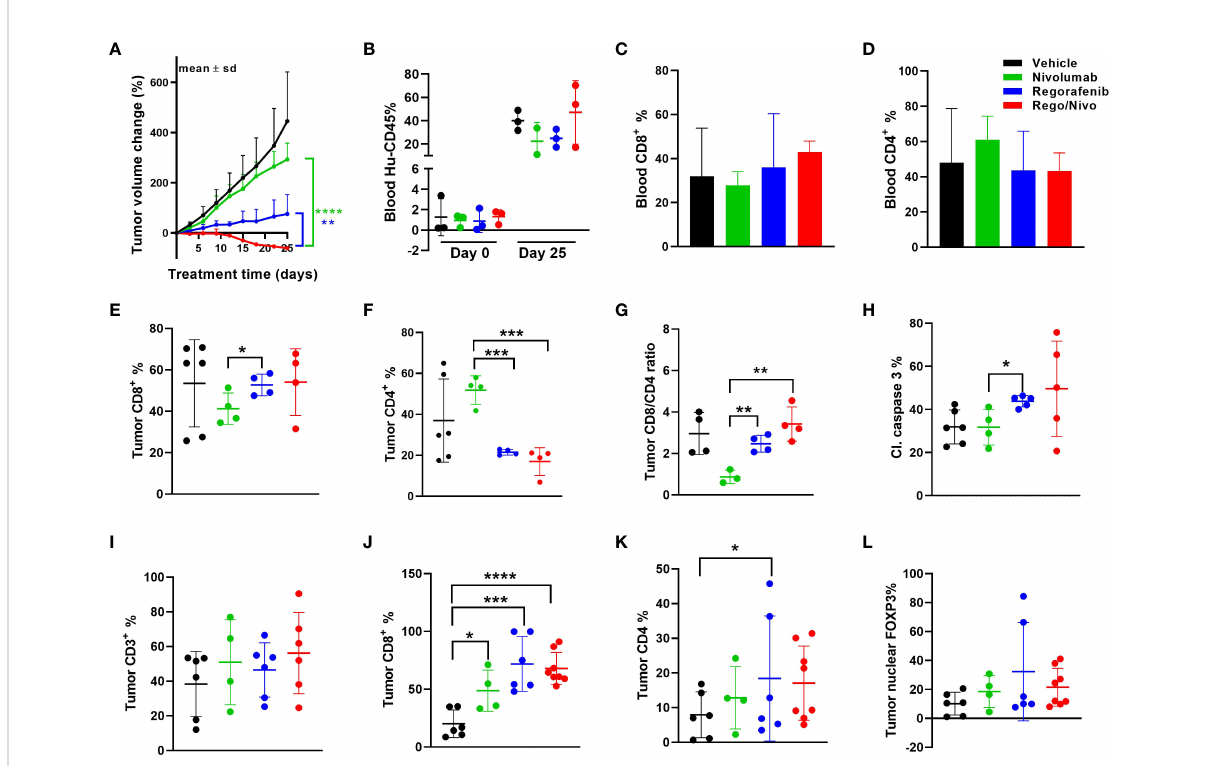
FIGURE 4 Results of anti-PD-1 and regorafenib combination therapy for MSS CRC model (A) Tumor volume change [ D V % =100*(V t -V 0 )/V 0 ] plots for the C1221 model engrafted with autologous PBMCs and given treatment with nivolumab and regorafenib (n=4-8 tumors/arm). (B) Human hCD45 + cell percentages in mouse blood before and after the experiment. (C, D) Percentages of CD8 + (C) and CD4 + (D) T cells (percent of CD45 + cells) in mouse blood at the experimental end point. (E, F) Tumor CD8 + (E) and CD4 + (F) T-cell percentages determined using fl ow cytometry (percent of CD45 + cells). (G) Tumor CD8 + :CD4 + T-cell ratios. (H) Cleaved caspase 3 + cell percentages in tumors assessed using immunohistochemistry. (I) Results of Immunohistochemical analysis of CD3 + T cells in tumors. (J , K) CD8 + (J) and CD4 + (K) T-cell percentages in tumors. (L) Nuclear FOXP3 + cell percentages in tumors assessed using immuno fl uorescent staining. The green lines and dots represent nivolumab-based treatment (every 5 days, 20 mpk), the blue lines and dots represent regorafenib-based treatment (everyday, 10 mpk), and the red lines and dots represent combination treatment. All P values ≤ 0.05 were represented as *, P values ≤ 0.01 were represented as **, P values ≤ 0.001 were represented as ***, and P values ≤ 0.0001 were represented as